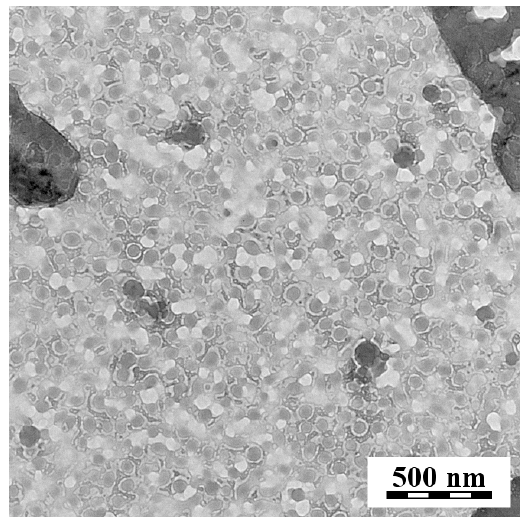
Figure 2. TEM image of dried HF polymer nanoparticles. The scale bar represents 500 nm.